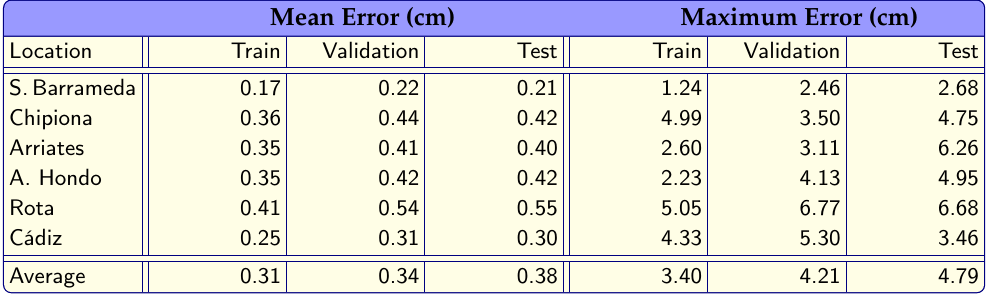
Table 9. Mean and maximum absolute errors for the reference NN model (23) for the predicted maximum heights. Mean Error (cm) Maximum Error (cm) Location Train Validation Test Train Validation Test